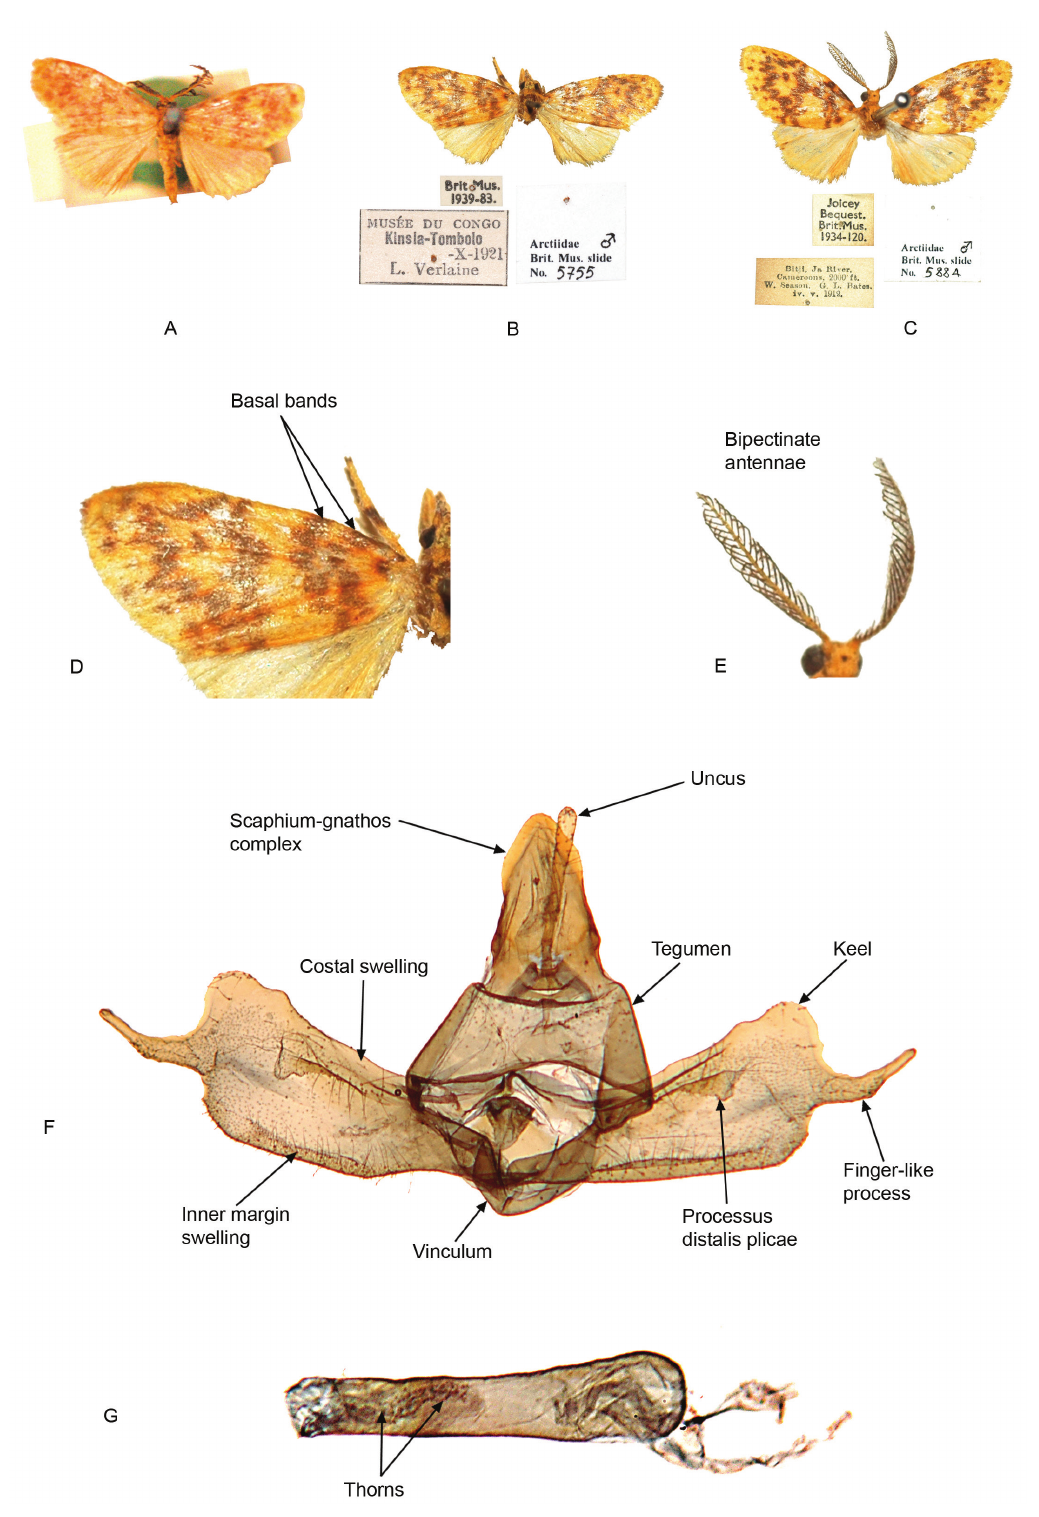
Fig. 1. Parafrasura pectinella (Strand, 1922) . A . Holotype ♂, Angola, in BMNH. B . ♂, Democratic Republic of the Congo, in BMNH. C . ♂, Cameroun, in BMNH. D . Enlarged Fig. B, showing the basal bands of the forewing. E . ♂, head of Fig. C enlarged, showing the bipectinate antennae. F . ♂ genitalia, g.sl. BM ARCT 5741, Chad. G . Aedeagus, g.sl. BM ARCT 5741,